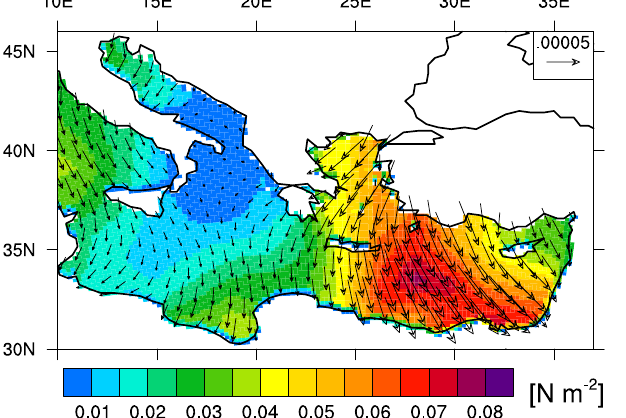
Fig. 15. Temperature change through vertical advection averaged between 12 and 42m of depth (colours) and vertical velocities (fill patterns, positive values for upward velocities) in July for